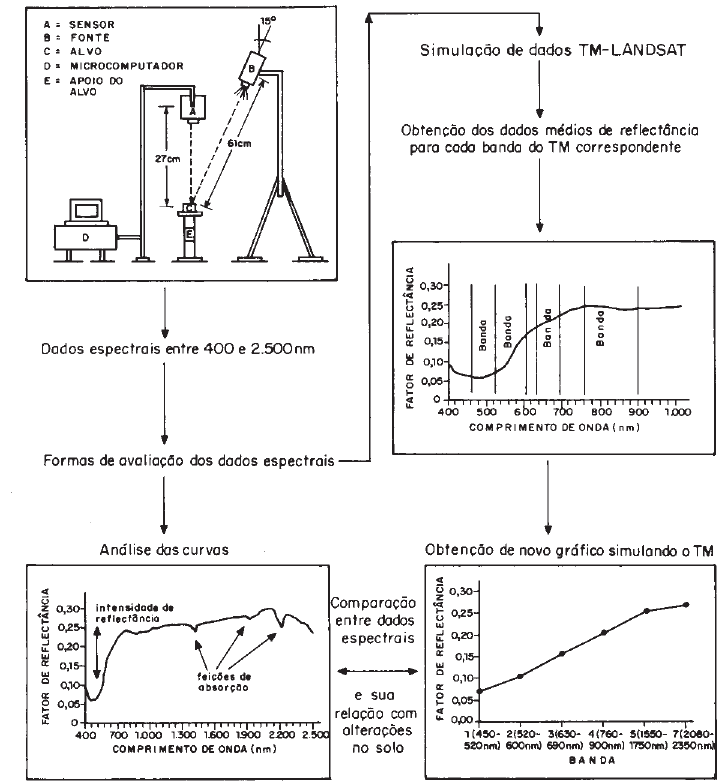
Figura 1. Fluxograma ilustrando a obtenção dos dados espectrais e sua